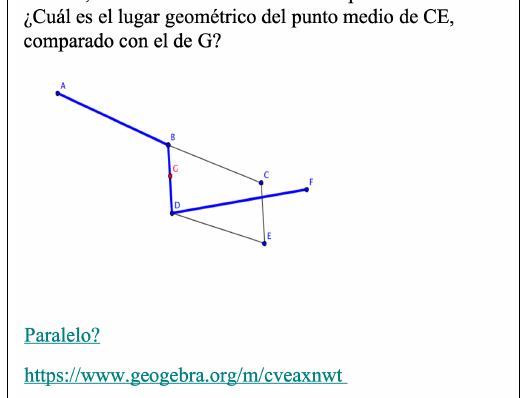
Figure 1. One of the tasks proposed to the students: In blue, the Watt mechanism. G is the midpoint of BD. What is the locus of the midpoint of CE, compared to that of